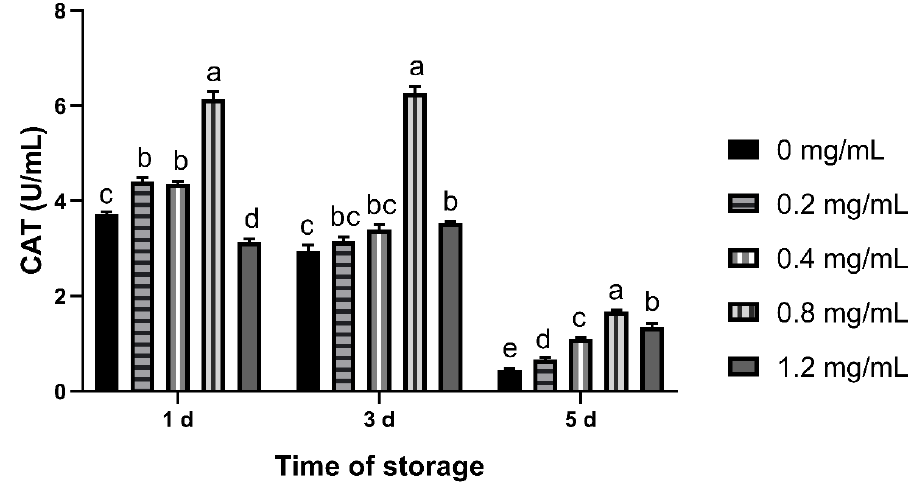
Figure 2. Effects of CGA with different concentrations on CAT activity of chilled ram semen. Note: Different letters above the column indicate significant difference, the same or containing the same letter indicate insignificant difference.